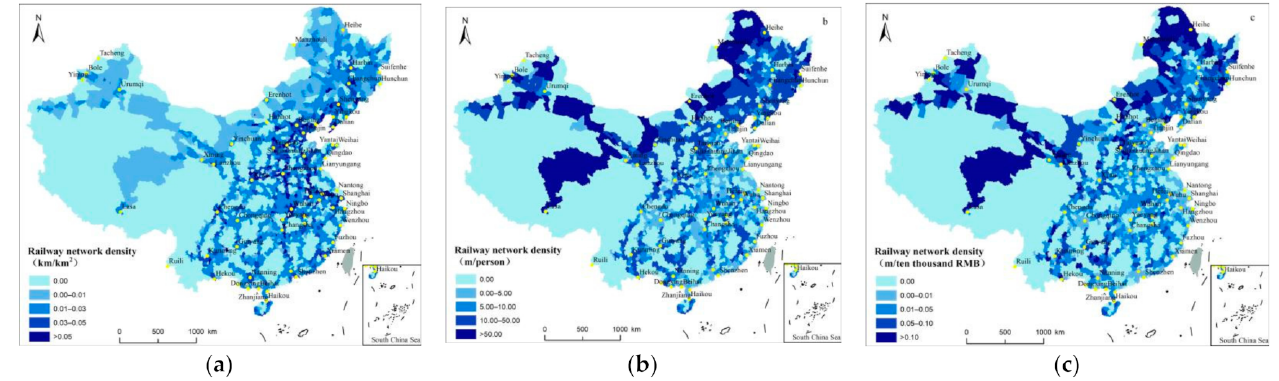
Figure 4. Distribution pattern of railway network density. ( a ) Distribution pattern of traditional railway network density; ( b ) distribution pattern of population-based railway network density; ( c ) distribution pattern of economy-based railway network density.